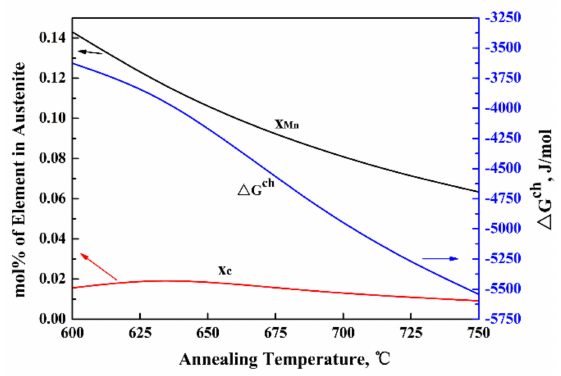
Figure 12. Chemical driving force diagram of martensitic